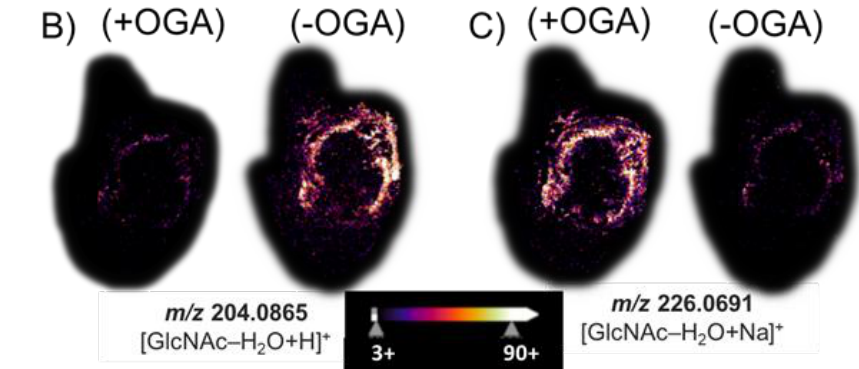
Figure 4. ( A ) The H&E stain of a hepatic tumor section contains an outlined tumor region composed of necrotic tumor with viable tumor region found at the interface to the healthy tissue. MALDI imaging of ( B ) the water-loss oxonium ion of GlcNAc, m / z 204.0865; and ( C ) the sodium-cationized water-loss oxonium ion, m / z 226.0691. (+) indicates the use of OGA, while ( − ) indicates an untreated serial section. The tissue sections were treated with PNGase F to remove all N-glycans prior to the OGA (+/ − ) treatment.